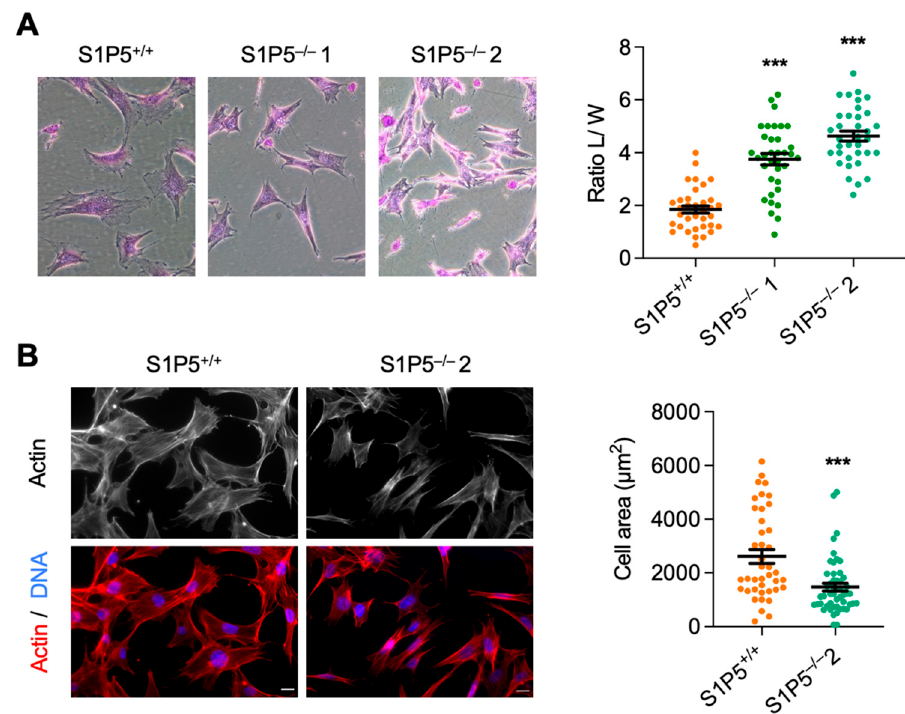
Figure 2. Morphological characterization of S1P5 +/+ and S1P5 − / − immortalized clones. ( A ), phenotype of immortalized MEFs. Representative phase contrast images from low confluence cultures of S1P5 +/+ and S1P5 − / − cells at passage 18 after fixation and staining with crystal violet are shown in the left panel. Right panel: quantification of the ratio of maximal length (L) versus cell width (W) from n = 30 cells per condition from four independent experiments performed between passages 18 to 22. Each dot represents a cell (***, p < 0.0001). ( B ), cell area and actin organization in S1P5 − / − cells. S1P5 +/+ and S1P5 − / − 2 MEFs were plated on coverslips and 24 h later were fixed and stained for F-Actin (Phalloidin-red) and DNA (Hoechst 33,342-blue). The left panel shows representative images. Scale bar, 10 µ m. The right panel shows the quantification of the cell area in µ m 2 based on F-Actin staining. The mean surface area was calculated using ImageJ software. The data are represented in a dot plot, where each point represents one cell and the black lines indicate means ± SEM (***, p < 0.0001; S1P5 +/+ , 2612 ± 255, n = 41; S1P5 − / − 1467 ± 147, n = 50).